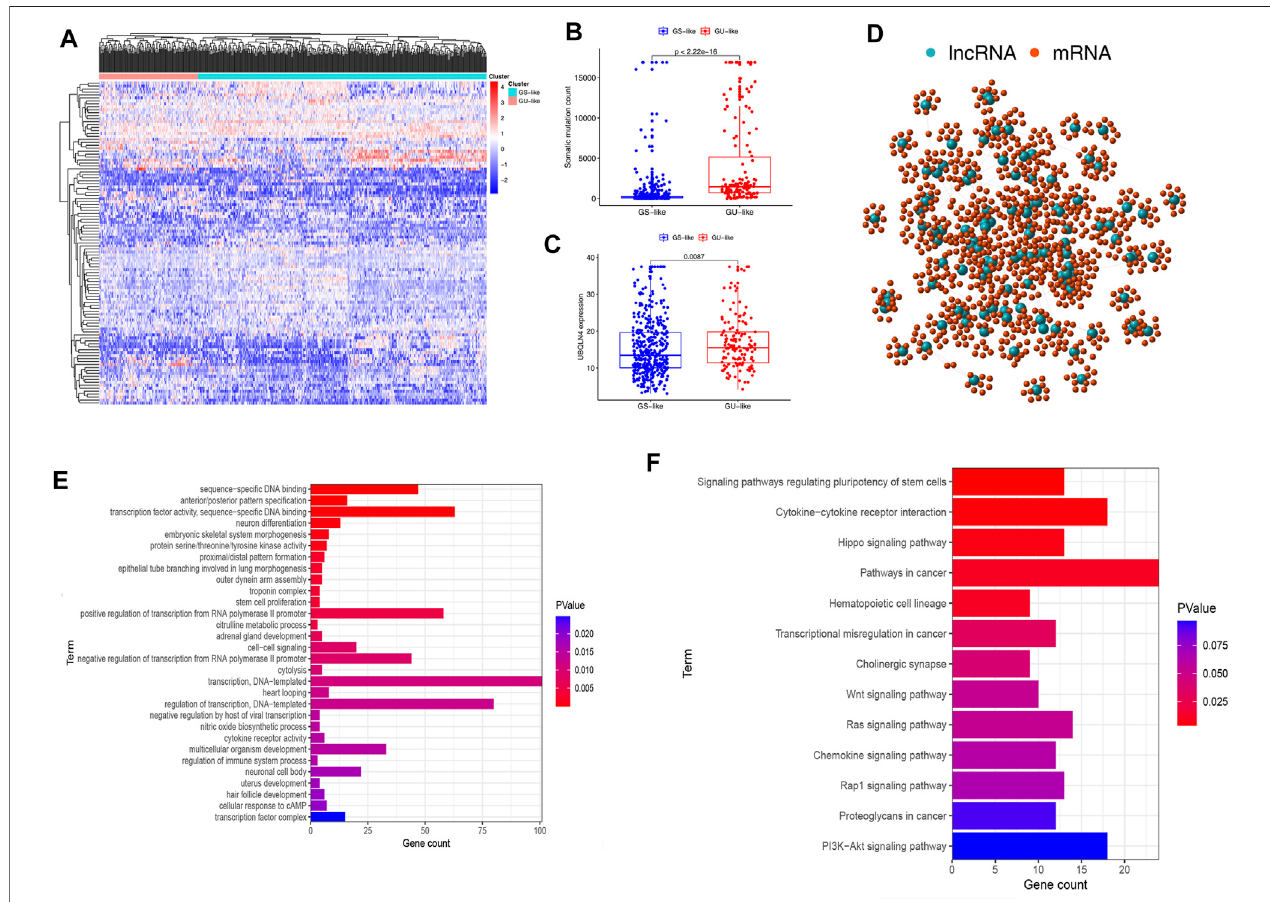
FIGURE 2 | Cluster analysis and functional annotation of genomic instability-related lncRNAs in patients with endometrial carcinoma. (A) Unsupervised clustering was performed on patients with endometrial carcinoma based on the expression patterns of 128 candidate genomic instability-related lncRNAs. (B) Level of somatic mutation count in GU and GS groups. (C) Expression level of UBQLN4 in GU and GS groups. (D) Co-expression network of genomic instability-related lncRNAs and mRNAs based on Pearson correlation coef fi cient. (E,F) Results of Gene Ontology analysis and Kyoto Encyclopedia of Gene and Genomes pathway enrichment analysis for lncRNAs co-expressed